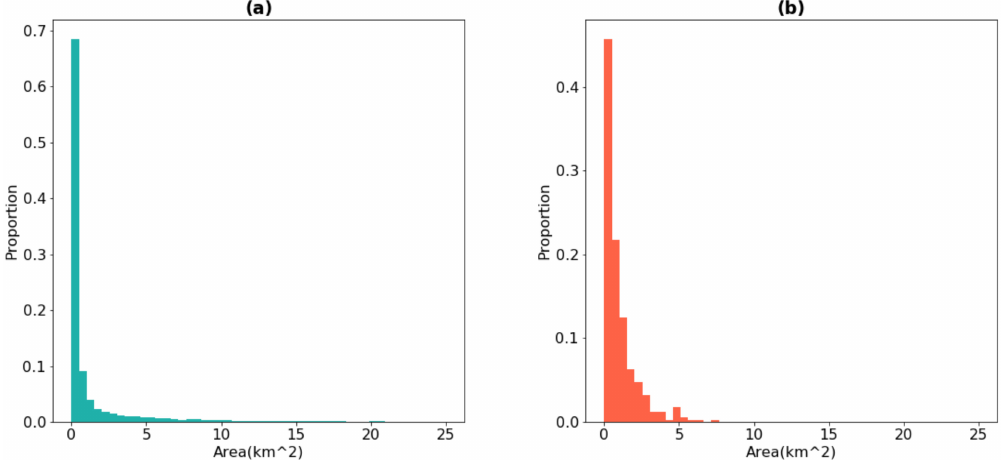
Figure 7. The structure of area distribution of Voronoi polygon for the: ( a ) whole of Beijing and ( b ) study sample